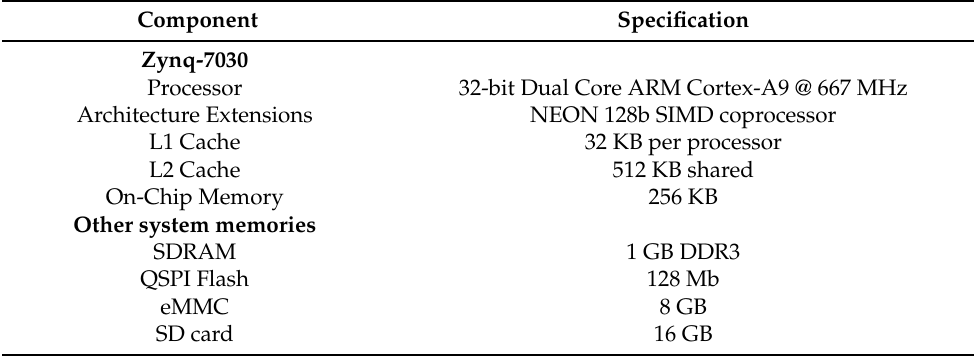
Table 2. On-board Processing Unit technical